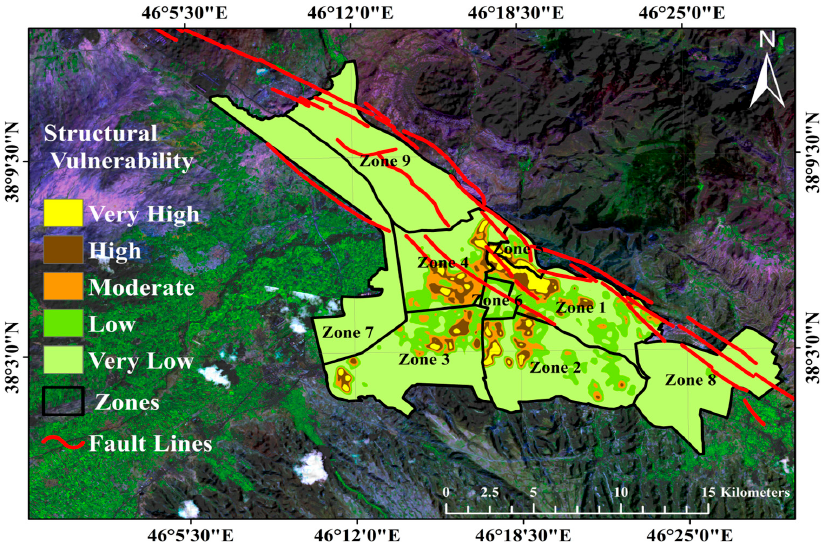
Figure 6. Residential buildings vulnerability distribution showing structural vulnerability in Tabriz municipality.